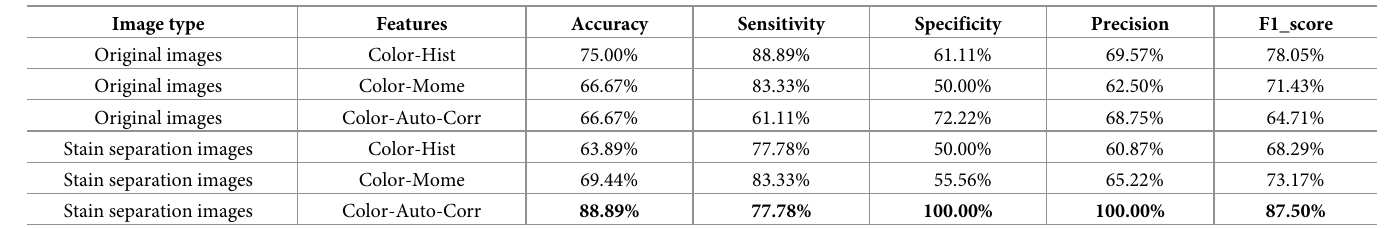
Table 4. Comparison of different color feature methods at image-wise.